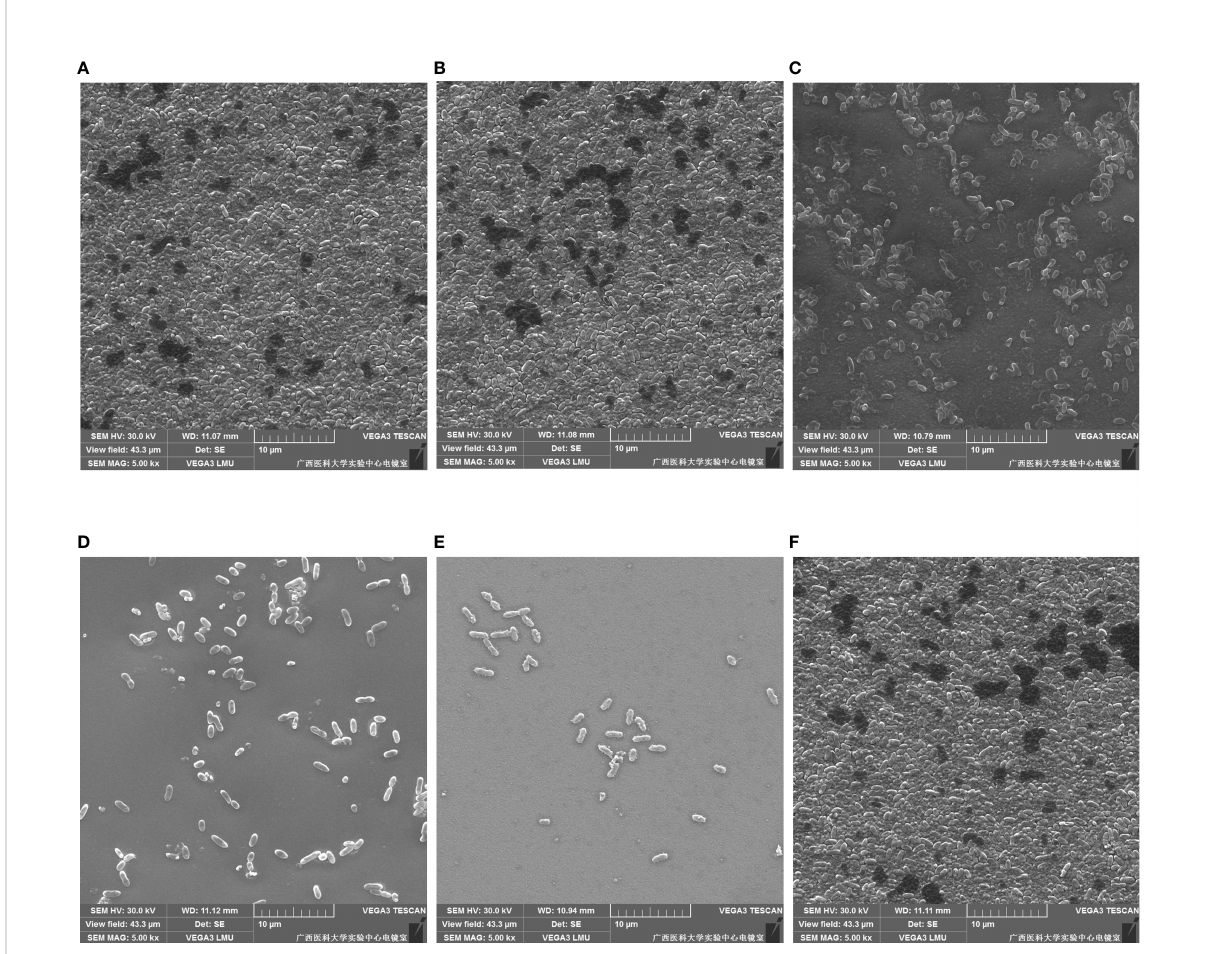
FIGURE 6 Eradication effect of daphnetin (DAP) against bio fi lm of P. aeruginosa is observed by electron microscopy after 24 h in culture (×5000). (A) PAO1 group. A large number of aggregated P. aeruginosa form the bio fi lm. (B) DAP group with fi nal concentration of 0.222 (mg/mL). (C) DAP group with fi nal concentration of 0.445 (mg/mL). (D) DAP group with fi nal concentration of 0.890 (mg/mL). (E) DAP group with fi nal concentration of 1.781 (mg/mL). In the DAP groups, bacterial aggregation decreased with increasing concentration. (F) Dimethyl sulfoxide (DMSO) group, drug solvent negative control group (no